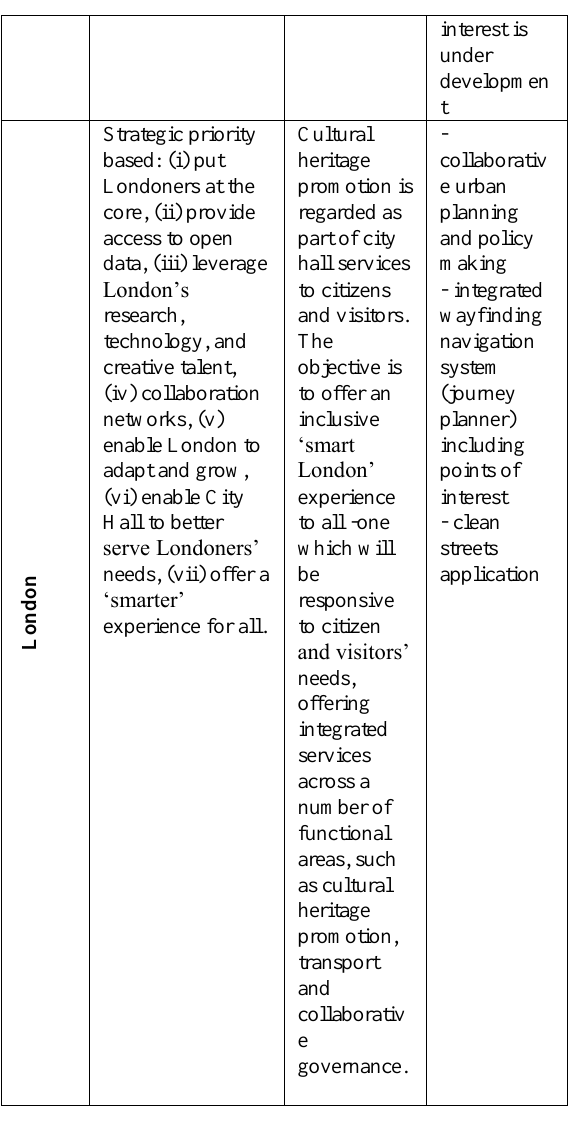
Table 1. Tabular display with field research findings across the three cases (authors’